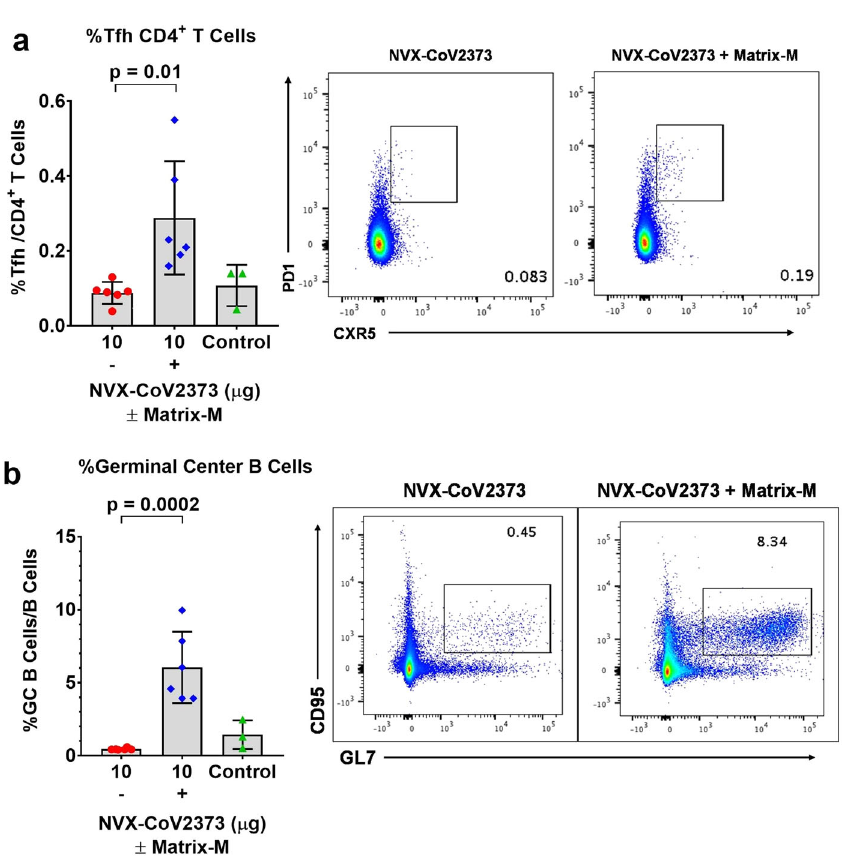
Fig. 7 Frequencies of follicular helper T cell (Tfh) and germinal center (GC) B cells generated by immunization with NVX-CoV2373 and Matrix-M adjuvant. Mice were immunized with NVX-CoV2373 with and without Matrix-M adjuvant and splenocytes were collected 7 days after the second immunization. a The frequency of splenic Tfh cells (CXCR5 + PD-1 + CD4 + ) in the CD4 T population. b The frequency of splenic germinal center (GC) B cells (GL7 + CD95 + CD19 + ) in B cells. Bars represent the mean values and the error bars indicate ±SD of triplicate assays. Colored symbols indicate individual animal values. Comparisons between groups receiving NVX-CoV2373 with and without adjuvant was performed by Student ’ s t -test (unpaired, two tail). Source data are provided as a Source Data fi protein nanoparticle vaccines 24 . The mechanism of action of the saponin-based Matrix-M adjuvant has been described by Reimer et al. 25 , and further characterized by Magnusson et al. 26 . Sub- cutaneous injection of Matrix-M has been shown to promote the recruitment of leukocytes to local draining lymph nodes and the spleen in mice, along with an increase in activation marker CD69 on monocytes and T-, B-, natural killer, and dendritic cells in the draining lymph nodes. It is hypothesized that Matrix-M induces a local transient pro-in fl ammatory response with recruitment, activation, and maturation of immune cells, speci fi cally stimulating dendritic cell uptake and processing of antigens with enhanced presentation 25 – 27 . In this study,